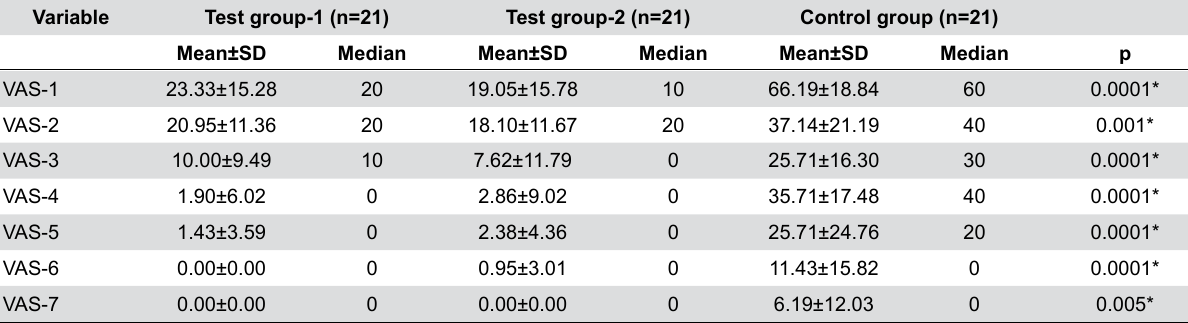
Table 3- Evaluation of patient’s post-operative